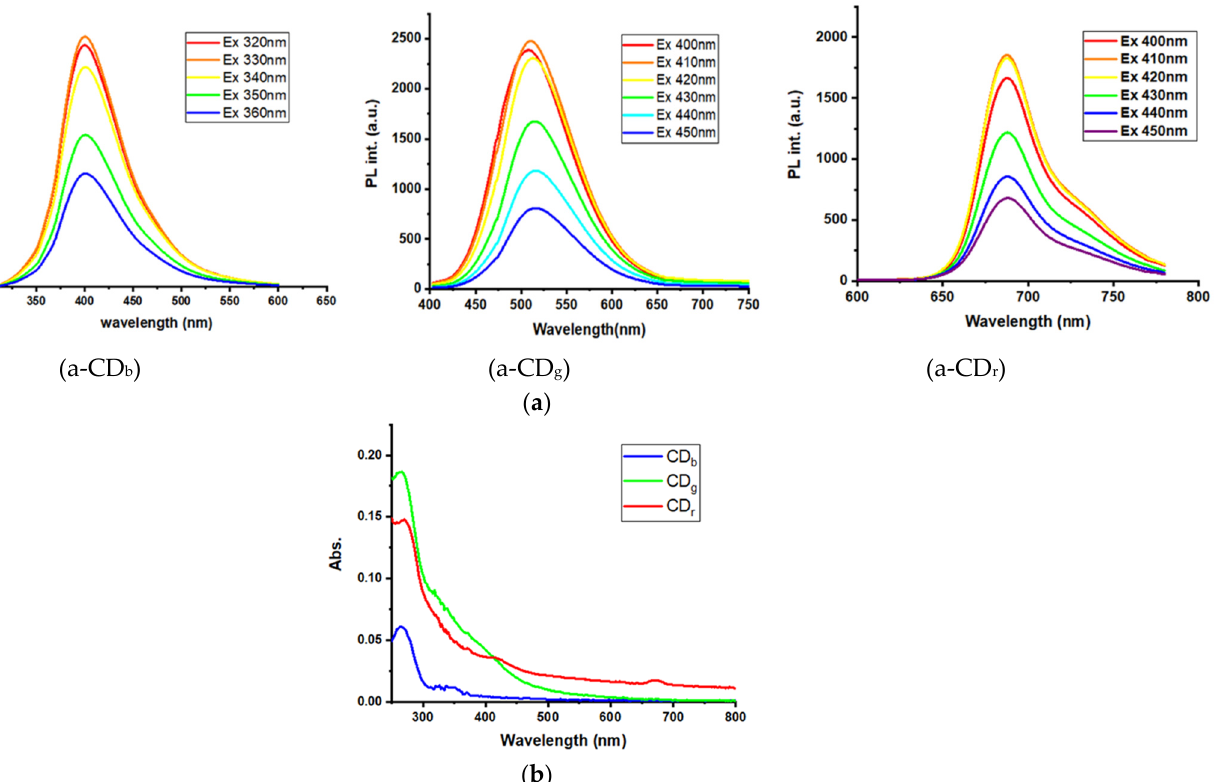
Figure 2. ( a ) Changes in the emission wavelengths of the maximal intensity of the three types of CD s (1 mg mL − 1 in PBS); ( b ) ultraviolet-visibleabsorption spectra of the three types of CD s (0.1 mg mL − 1 in